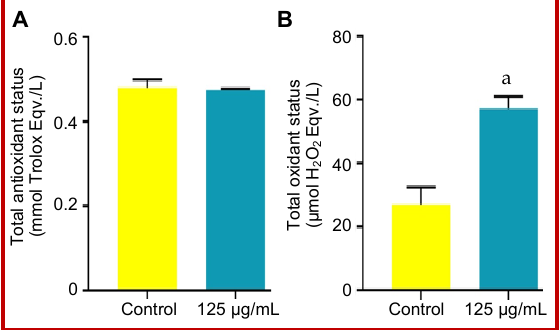
Figure 4: β -glucan at dose of 125 μg/mL didn’t not cause a significant change in the total antioxidant status level (A), but increased the total oxidant status level (B) of SH-SY5Y cells significantly. Results are represented as mean ± SEM of three samples. a p < 0.05 as compared to the control